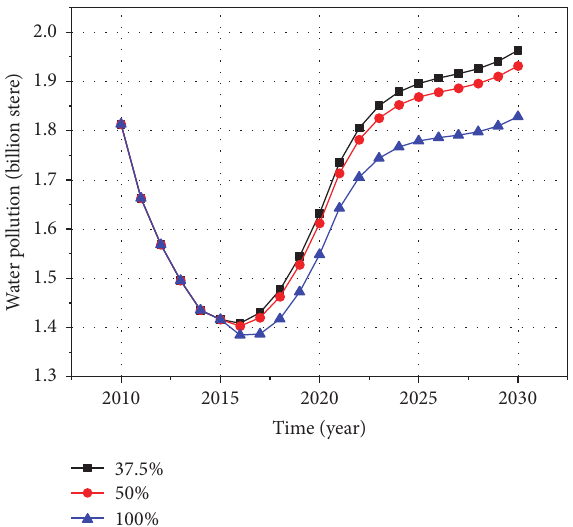
Figure 12: Total wastewater under different development patterns.